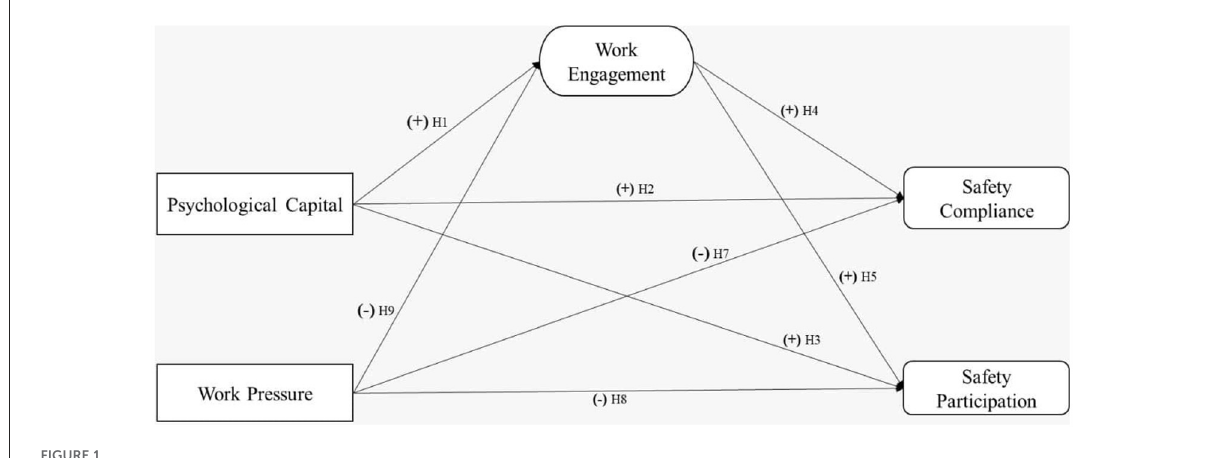
FIGURE1 Proposed research